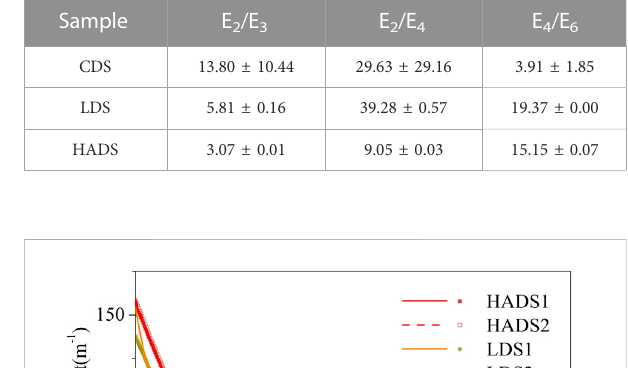
TABLE 3 Ratios calculated from absorbance data. Sample